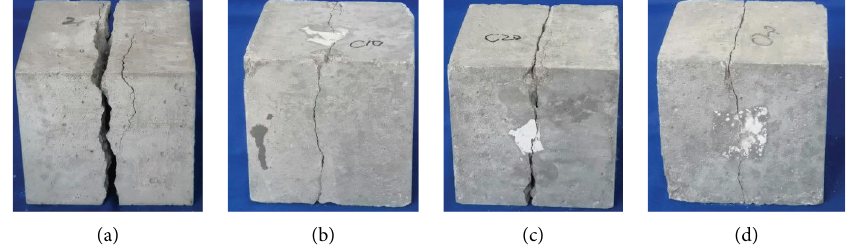
Figure 5: Splitting tensile test destructive form. (a) SAC. (b) LSAC-10. (c) LSAC-20. (d) LSAC-30.